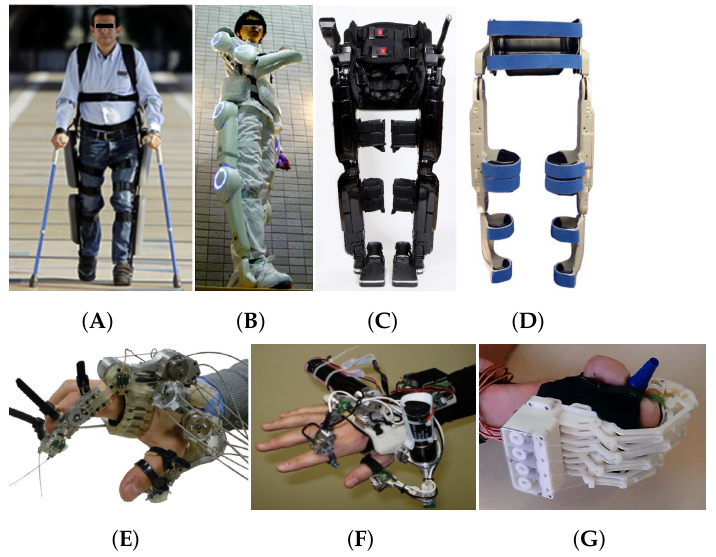
Figure 2. Wearable assistive robots with rigid and semi-rigid structure. Lower limb assistive robots: ( A ) ReWalk [12] (Reproduced with permission from Elsevier), ( B ) HAL [28] (Licensed under (CC BY 2.0)), ( C ) REX [32] (Licensed under (CC BY 4.0)), ( D ) Vanderbilt exoskeleton [33] (Reproduced with permission from Elsevier). Wearable assistive hands: ( E ) HandeXos-Beta [34] (Reproduced with permission from Elsevier), ( F ) HexoSYS [35] (Reproduced with permission from Elsevier), ( G ) HES Hand [36] (Reproduced with permission from